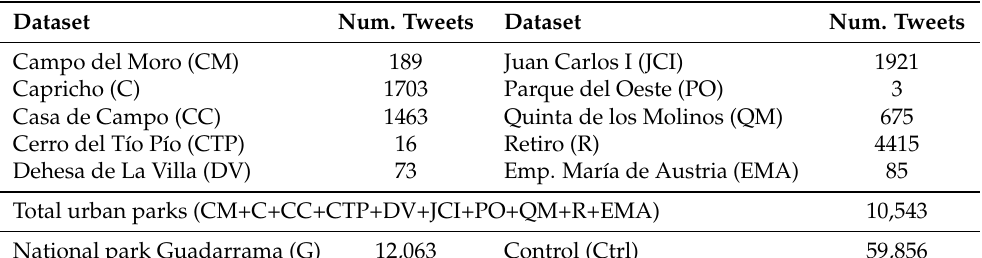
Table 1. Total number of tweets per data set.